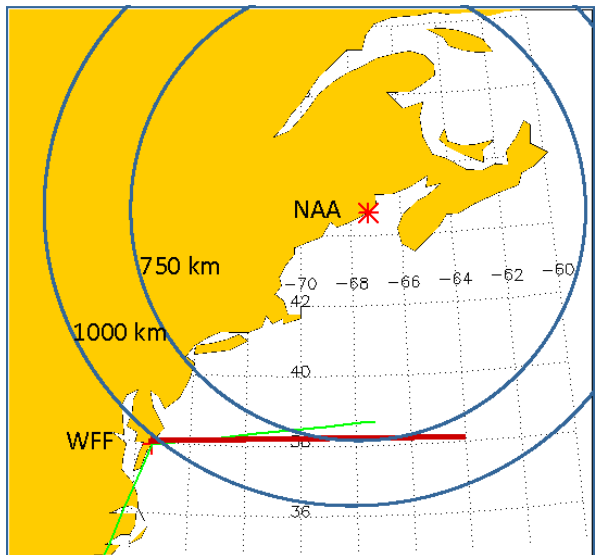
Figure 14. Proposed VIPER